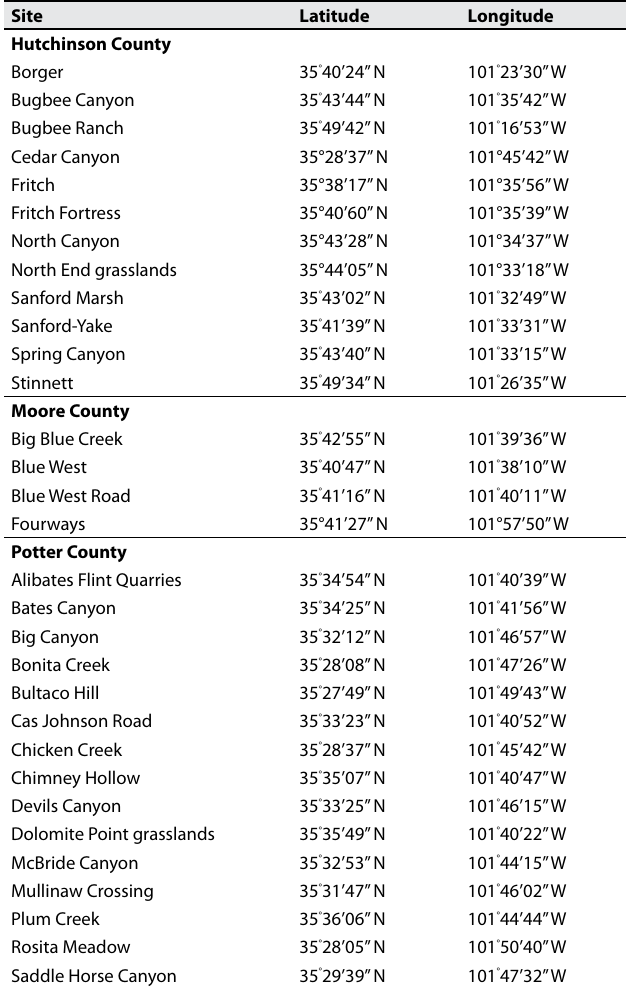
Table 4. Estimated centroids of locations mentioned in the text and Table